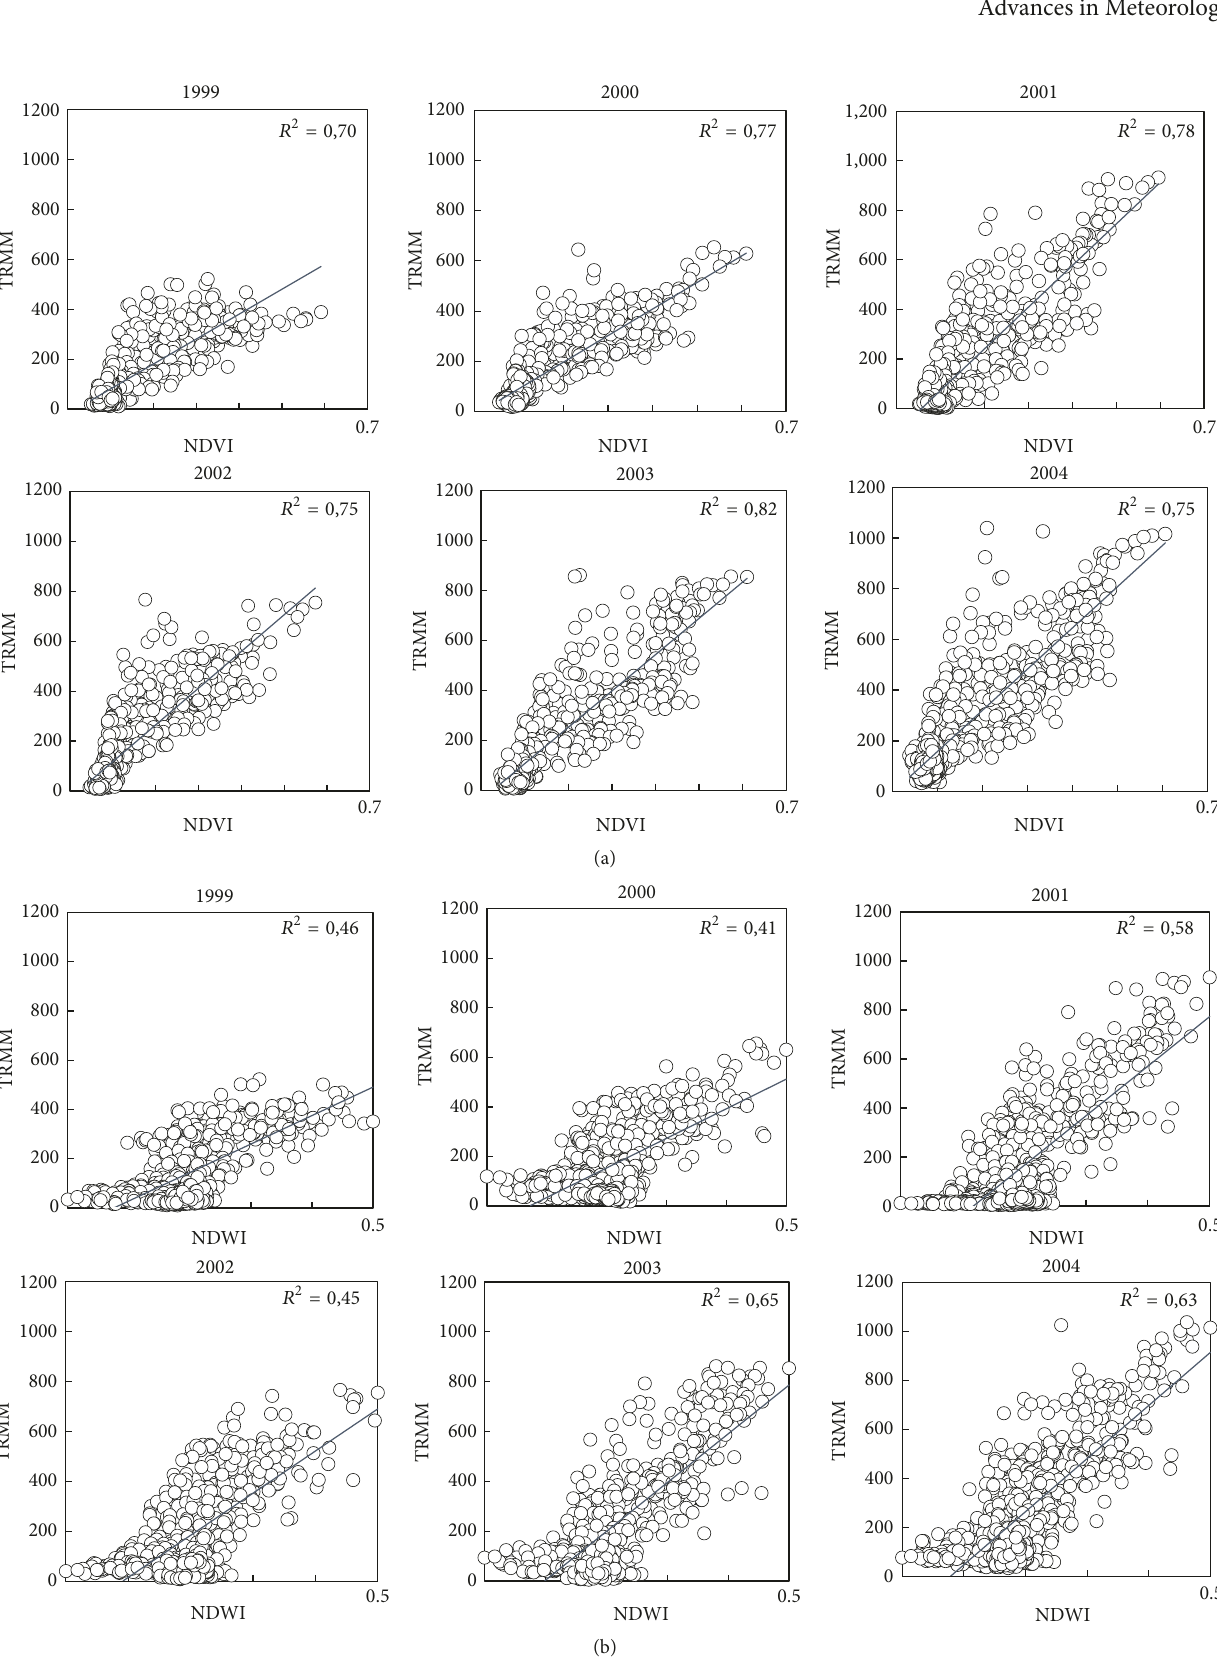
Figure 3: Scatterplot matrixes of TRMM versus NDVI (a) and TRMM versus NDWI (b) over the study period